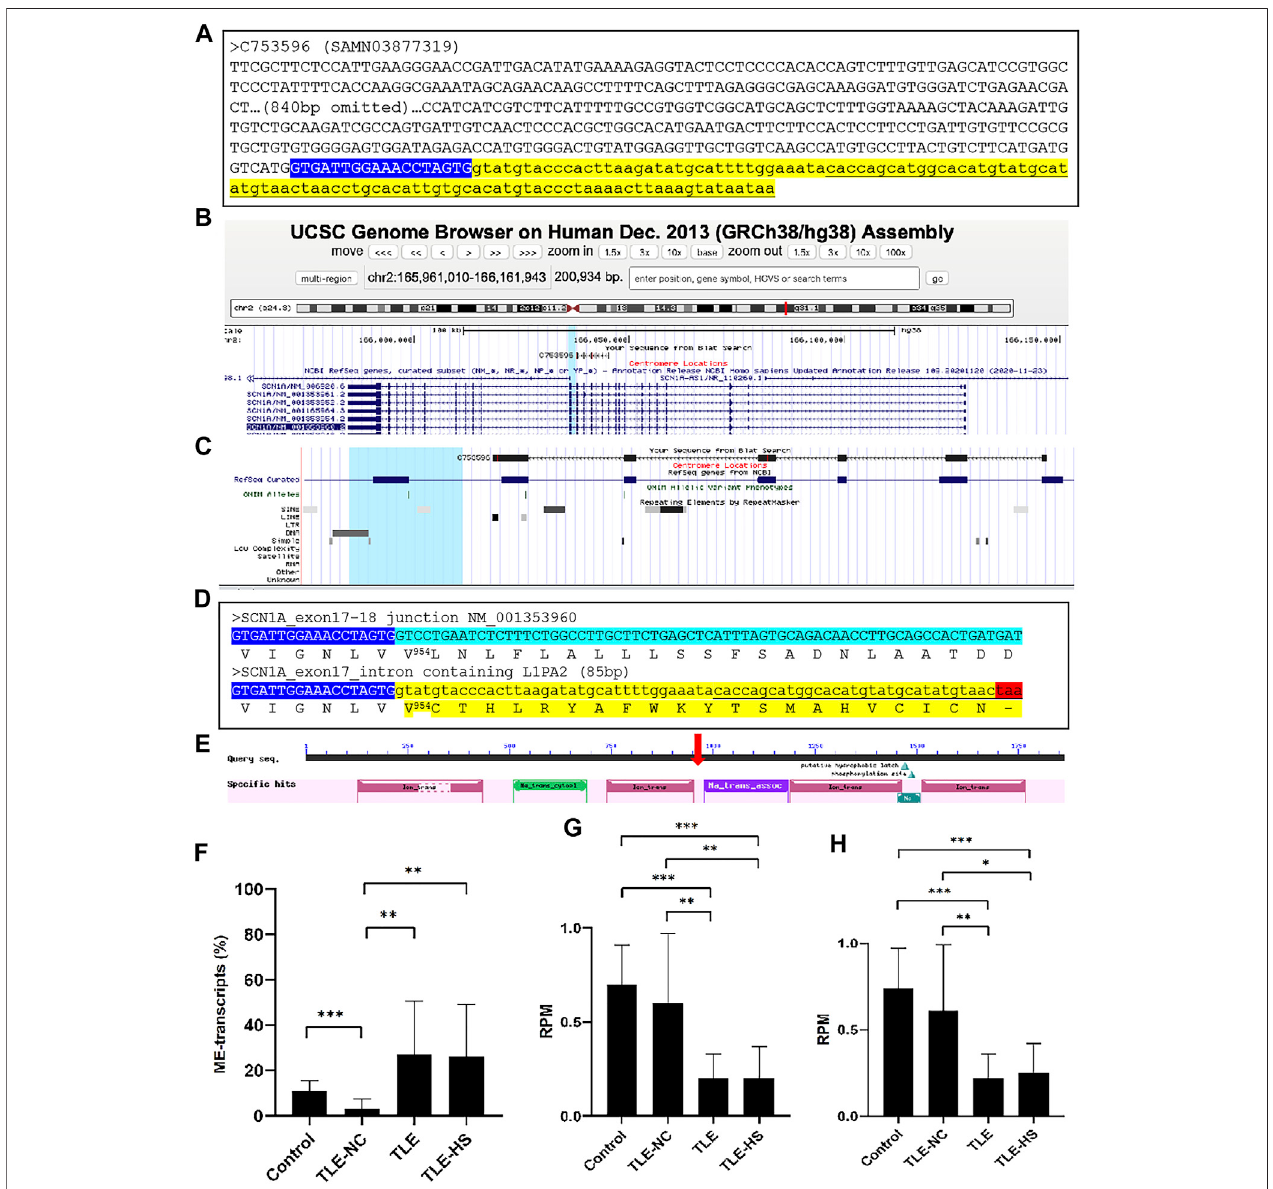
FIGURE 3 | Disruption of the open reading frame (ORF) by a mobile element (ME) in the transcript of the SCN1A gene. (A) . The sequence of a transcript scaffold (C753596 from SAMN03877319) for the SCN1A gene from the TLE-group in the fasta format. The ME sequence is indicated in underlined font in the yellow highlighted part, while the normal exon sequence is labeled in upper case and the intron sequence in lower case (B) . A screenshot showing the alignment of the ME-transcript sequence to the human genome in the UCSC Genome Browser, indicating the location of the alignment within the gene structure of SCN1A ; (C) . A zoomed-in picture of the alignment of the transcript sequence with the SCN1A gene with the repeat-track at the bottom, showing the ME-transcript sequence covering exon 13 to exon18ofthegeneandthelastpartoftheME-transcriptsequenceextendingbeyondthenormalsplicingjunctionofexon17tocoveran87-bpL1PA2elementfromthe LINE family (D) . Detailed sequence comparison between the normal transcript (top entry) and ME-transcript (bottom entry) at the junction of exon 17 and 18 of NM_001353960withthecDNAsequencesshownintheplusstrandofthemRNA.Theendoftheexon17sequenceisshowninbluebackgroundandwhitefont,andthe fi rst part of the exon 18 sequence is shown in green background (top entry), while the intron containing the ME sequence is shown in yellow background (bottom entry). The correspondingprotein sequence isprovided belowthe cDNAsequence ineach case withthe ME-transcript sequence having an early stopcodon asindicated bya “ - ” . The number in superscript indicates the position in the normal protein sequence (NP_001340889, 1980 amino acids in total length) at the point, after which the ME versiondivergedfromthenormalversion.ThecolorhighlightscorrespondtothoseinA (E) .AscreenshotoftheNCBICDDentryforthe SCN1A protein(NP_001340889) showing the conserved domain structure of the protein with the vertical red arrow indicating the approximate position of the truncation caused by the ME sequence (F – H) .ExpressionlevelofthenormalandabnormalME-transcript forthe SCN1A geneinthesamplegroupsfortheratiobetweenthenormal andME-transcripts (F) ;the reads per million total reads (RPM) of the normal transcripts (G) and total (H) , all based on the counting of raw reads supporting each of the two junction sequences representing the two splice forms. Information on the statistical signi fi cance of pairwise comparisons among the sample groups is provided at the top of the plots with p -value < 0.001 indicated by “ *** ” , p -value < 0.01 indicated by “ ** ” , and p -value < 0.05 indicated by “ * ”